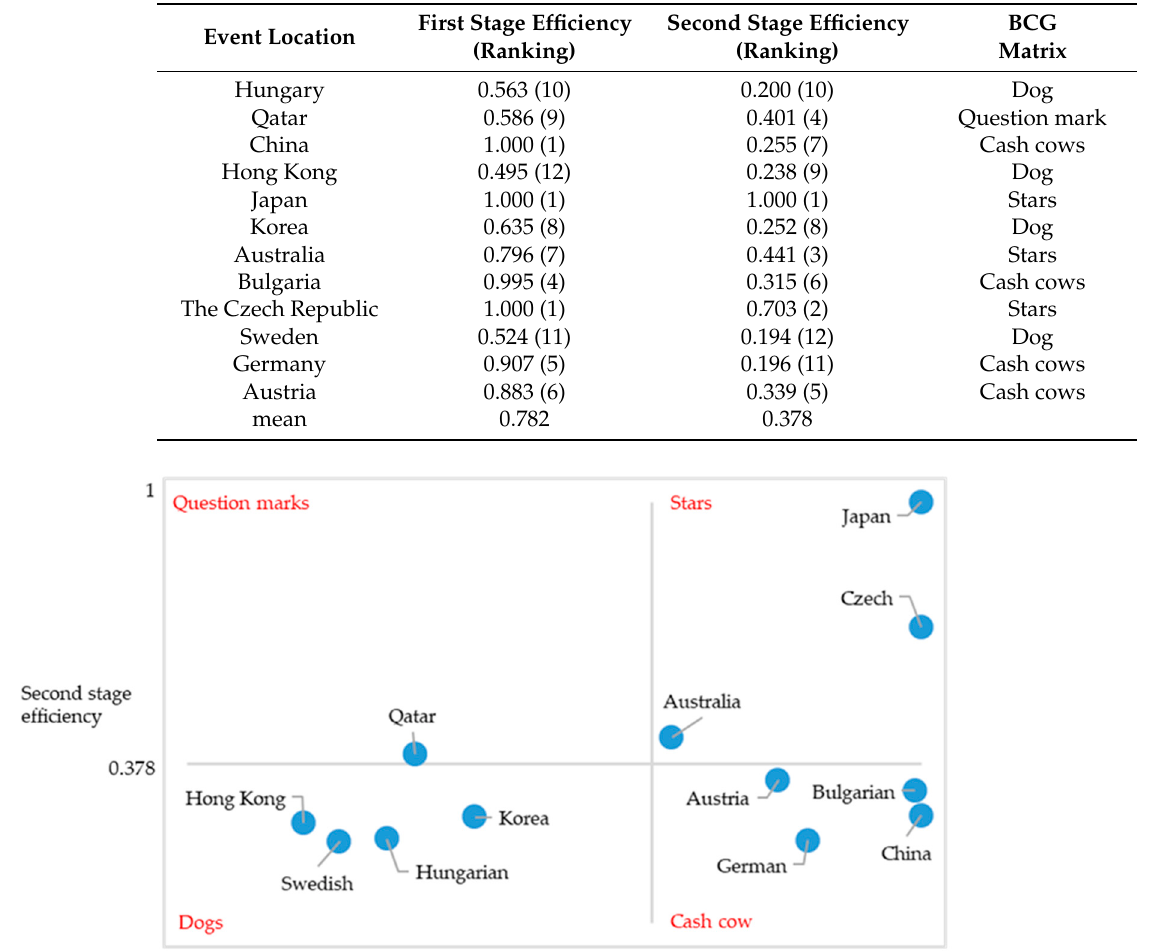
Table 8. Game participation strategy for the 2021 ITTF World Tour.